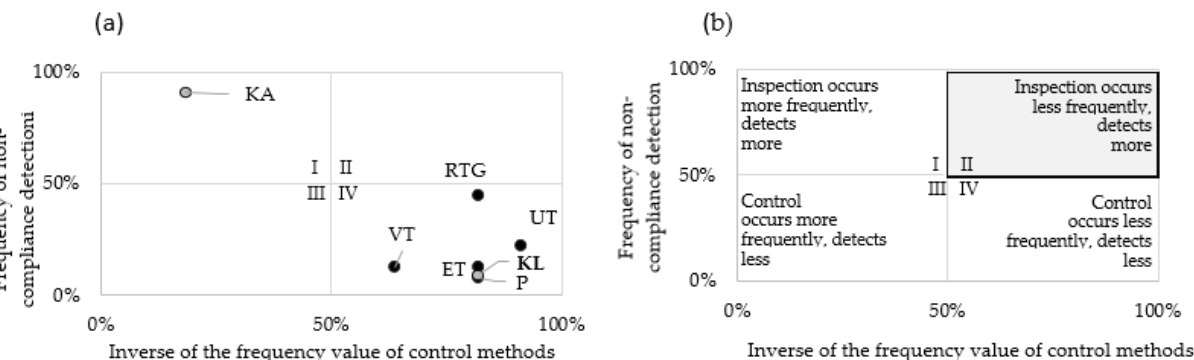
Figure 6. Matrix diagram showing ( a ) the relationship between the frequency of detection of non- compliance and the frequency of occurrence of a checkpoint in the context of its effectiveness ( b ) overview diagram.